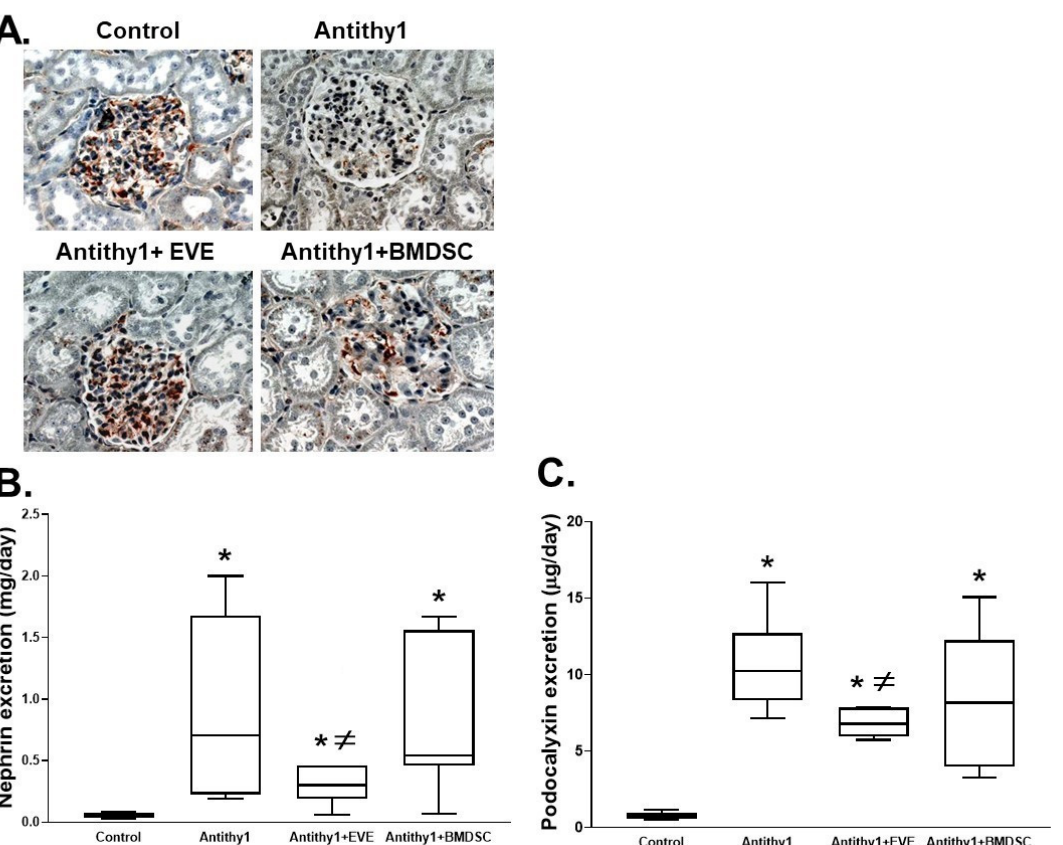
Figure 4. Representative images of immunohistochemical staining of glomerular nephrin expression in kidney sections ( A ), urinary nephrin excretion ( B ) and podocalyxin excretion ( C ) levels in control and anti-Thy-1-injected rats +/ − everolimus or BMDSC treatment. Anti-Thy-1 injection markedly increased the loss of glomerular nephrin, nephrinuria and podocalyxin excretion. Only everolimus lowered nephrin and podocalyxin excretion levels as markers of glomerular injury and restored the loss of glomerular nephrin expression in anti-Thy1-injected rats (n = 6–8, * vs. control and (cid:54) = vs. anti-Thy1-injected